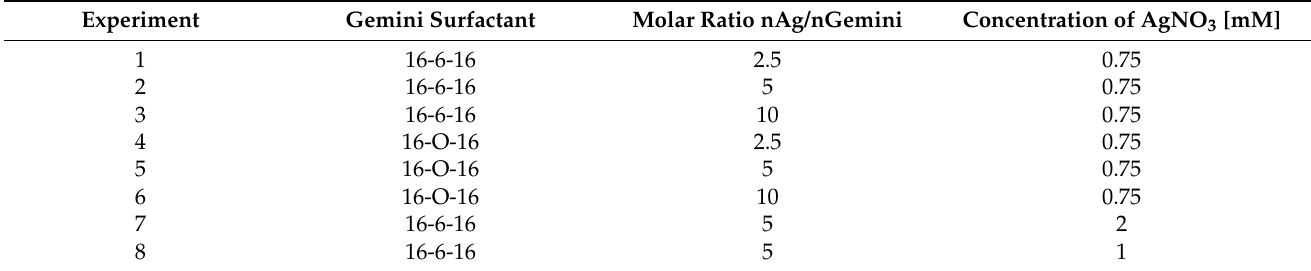
Table 2. Experimental data of different procedures for AgNPs obtaining.